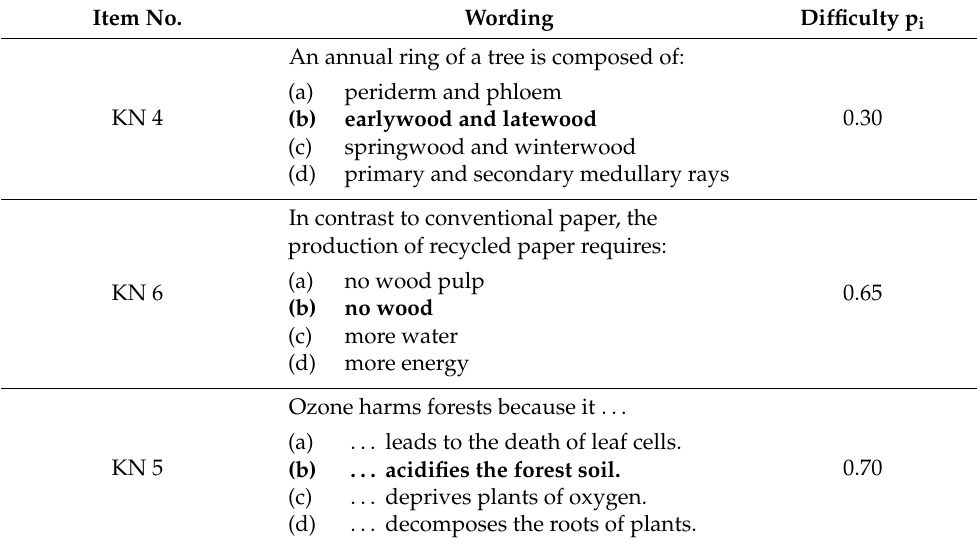
Table 1. Item examples of the knowledge test with difficulty indices (correct answer in bold). Item No. Wording Difficulty p i An annual ring of a tree is composed KN 4